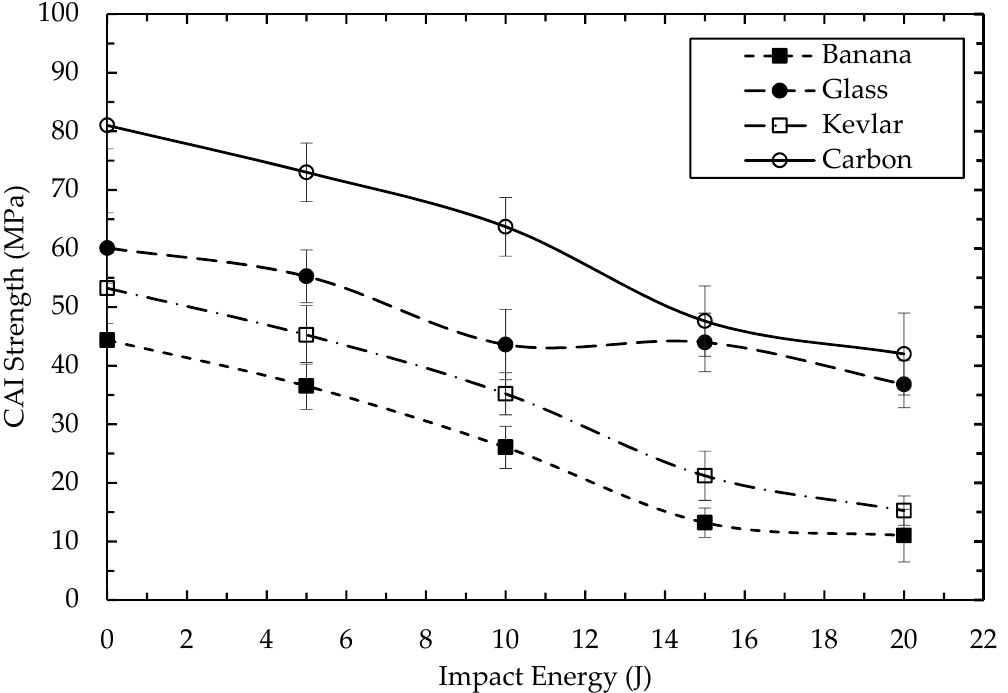
Figure 12. The average CAI strength versus impact energy traces of the sandwich structures.